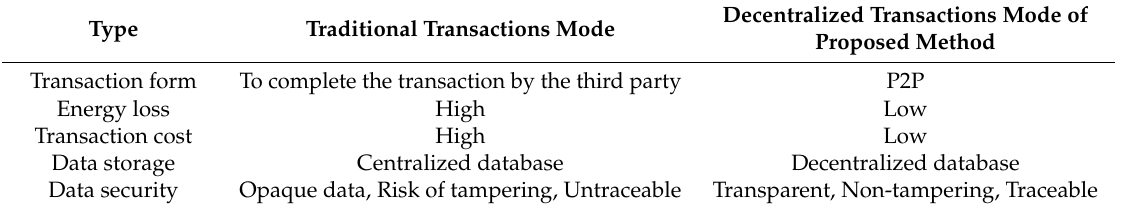
Table 6. Comparison of traditional transactions mode and decentralized transactions mode of proposed